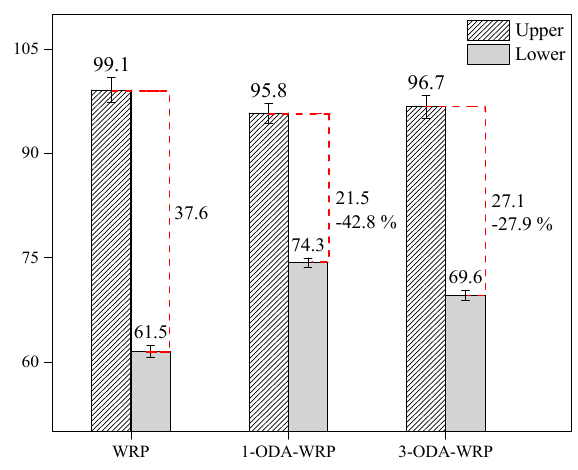
Figure 8. Segregation test results for various asphalt samples. 333